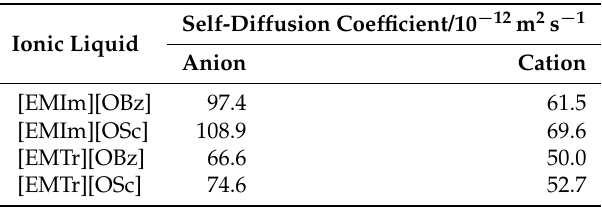
Table 3. Computed self-diffusion coefficients of the ions in the pure ILs from the MD simulations at 80 ◦